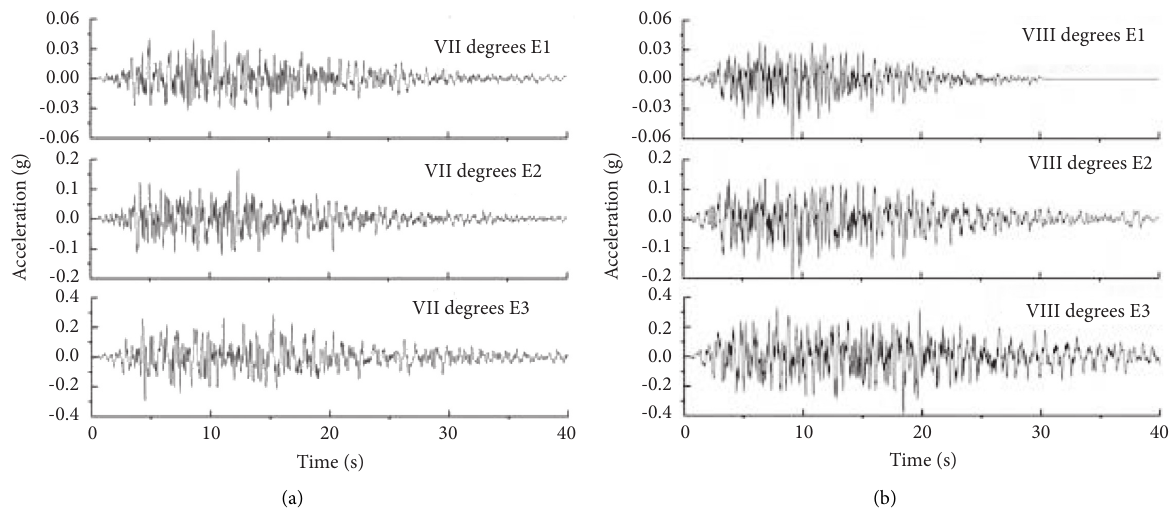
Figure 3: The time-history curve of bedrock motion with seismic fortification intensity. (a) VII degree. (b) VIII degree. unit: mm 663.4